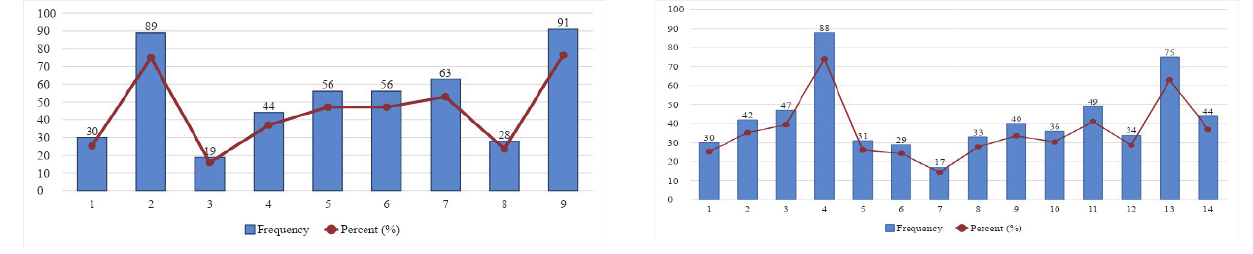
Fig. 1 . Characteristics of respondents Fig. 2. Characteristics of enterprises participating in this study